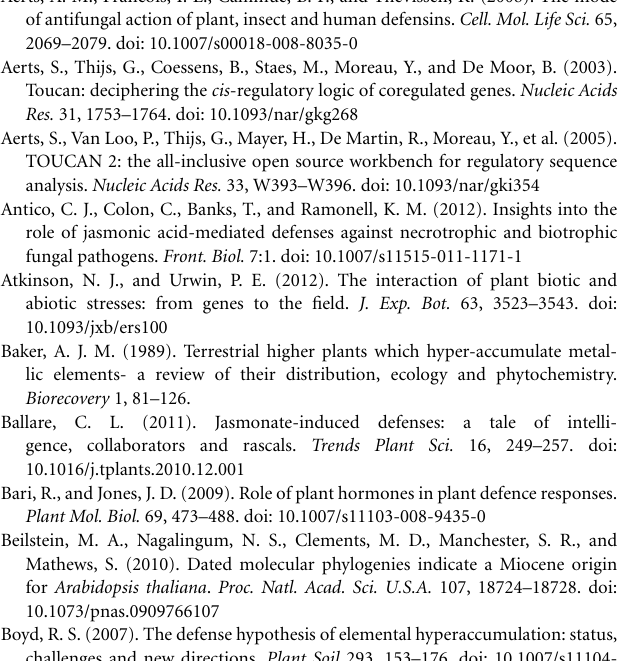
Supplementary Table 7 | Surface lesion measurements on infected A. thaliana and A. halleri leaves following B. cinerea inoculation. Supplementary File 1 | Nucleic sequences of the putative PDF1 promoter region used for in silico motif